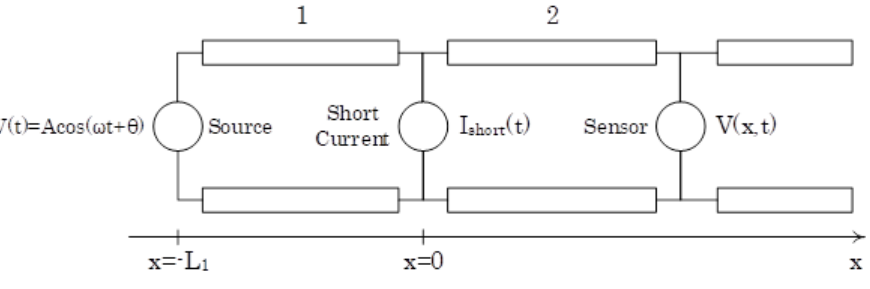
Figure 5. Detailed short in the transmission line